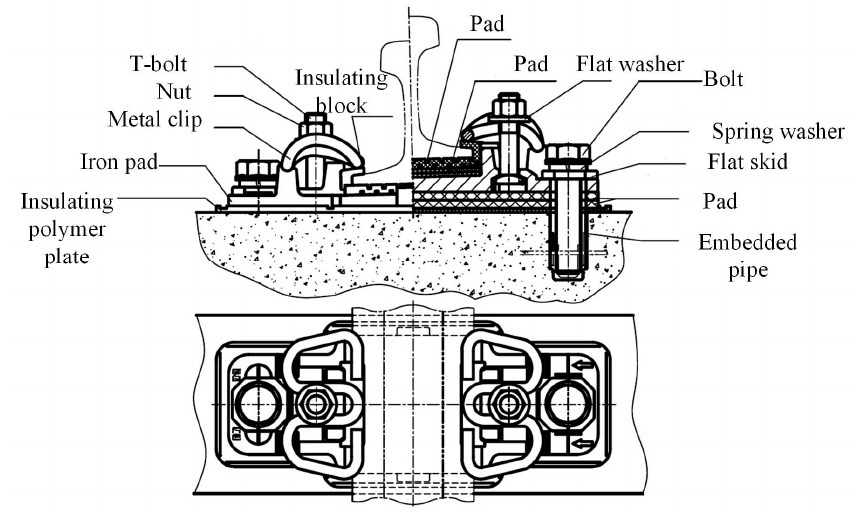
Figure 1. Assembly diagram of the WJ-7 fastening system.